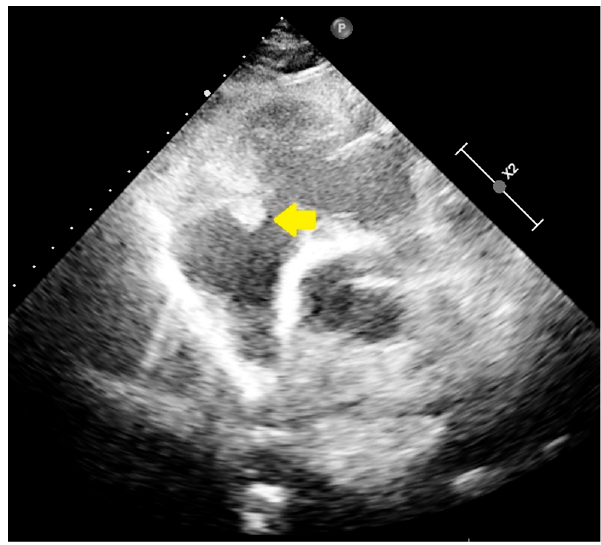
Figure 1. Transthoracic echocardiogram (TTE) showing infiltration by lymphoma in right atrium.